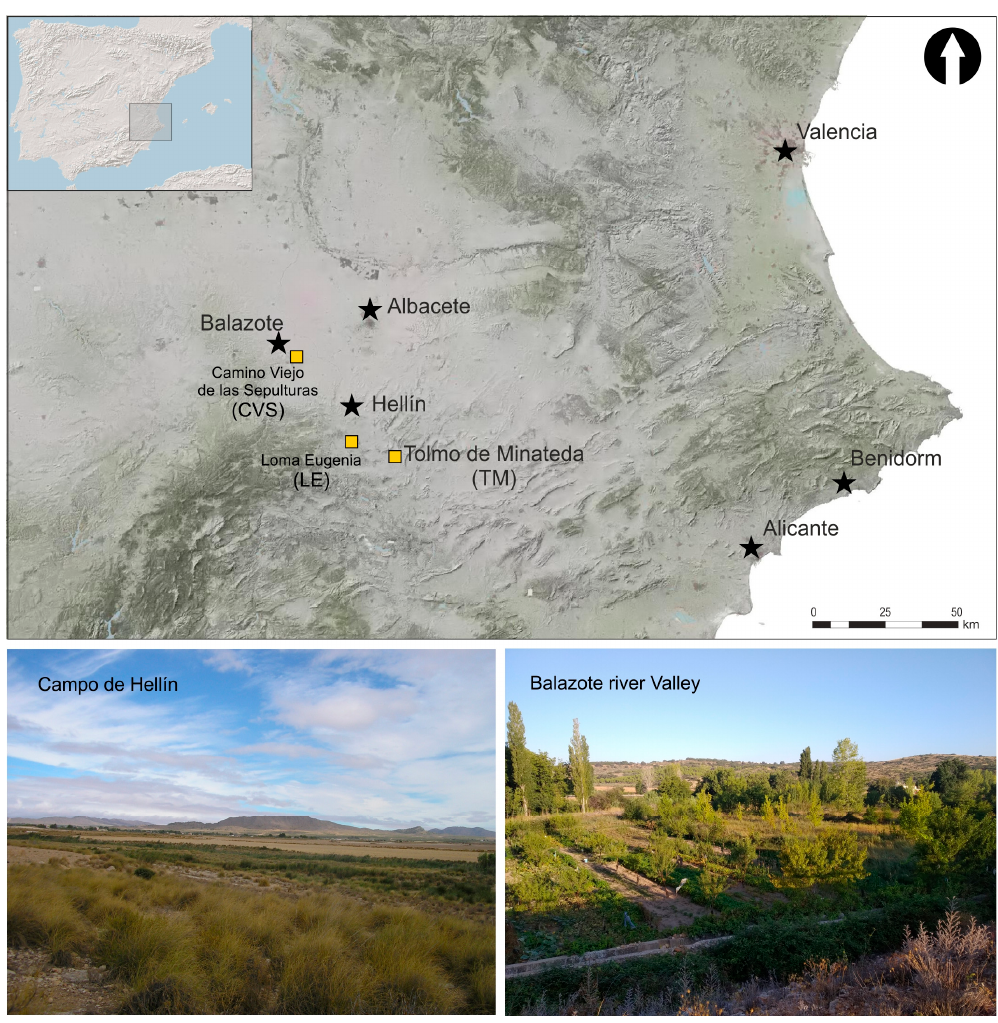
Figure 1. A location map of the study areas, showing the main settlements analysed and the views of the landscapes at the two study areas.